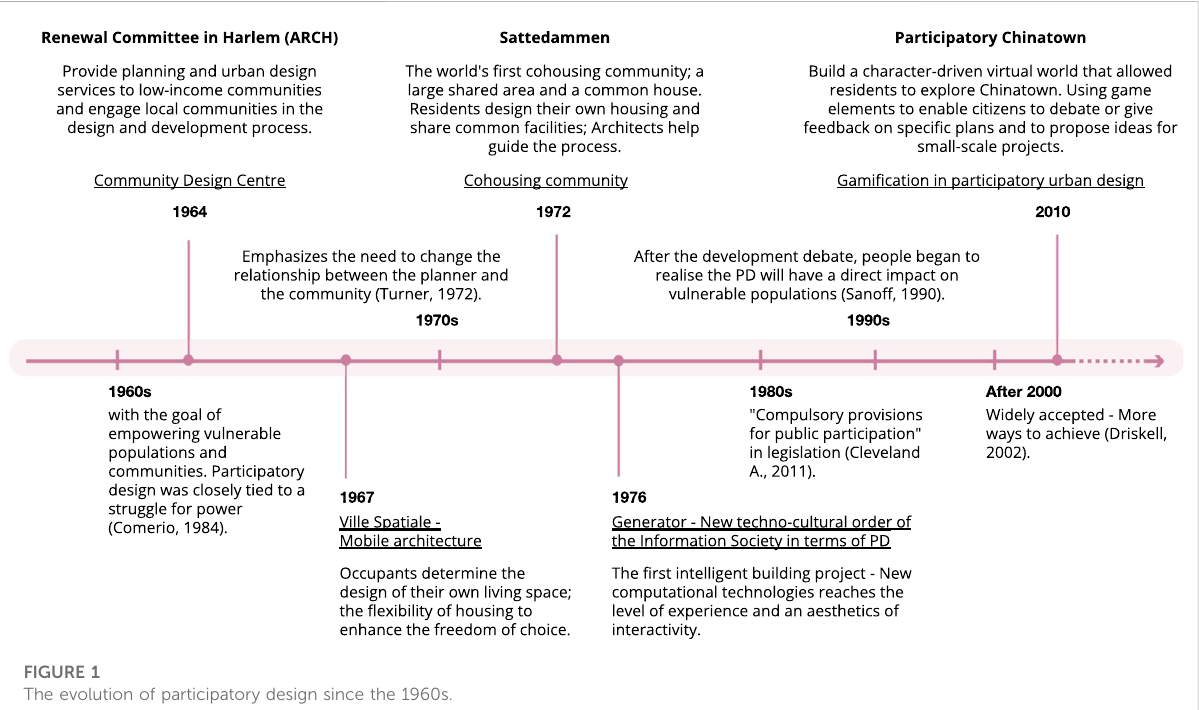
FIGURE 1 The evolution of participatory design since the